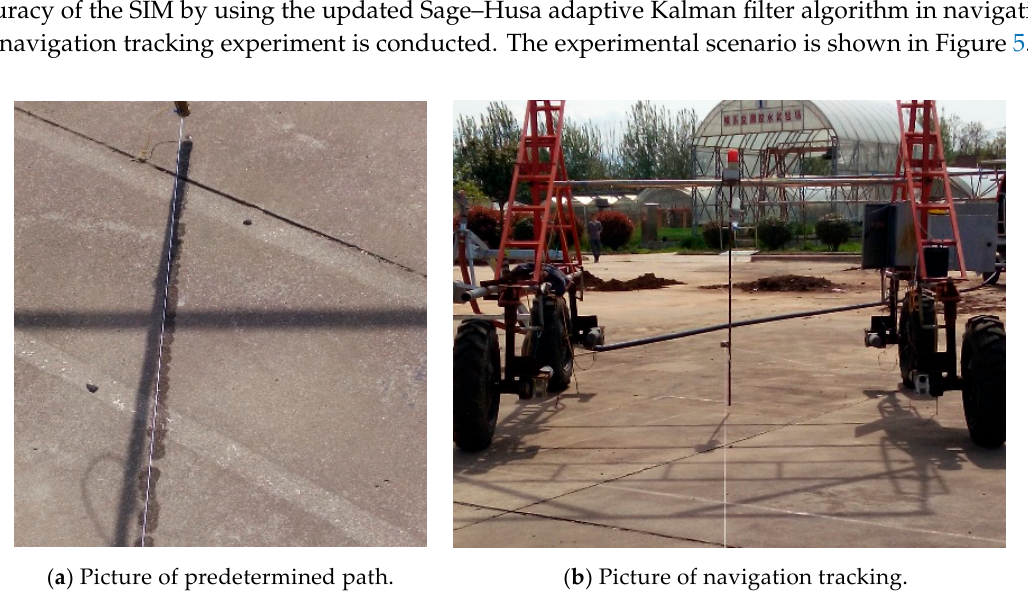
Figure 5. Experimental verification scenario.